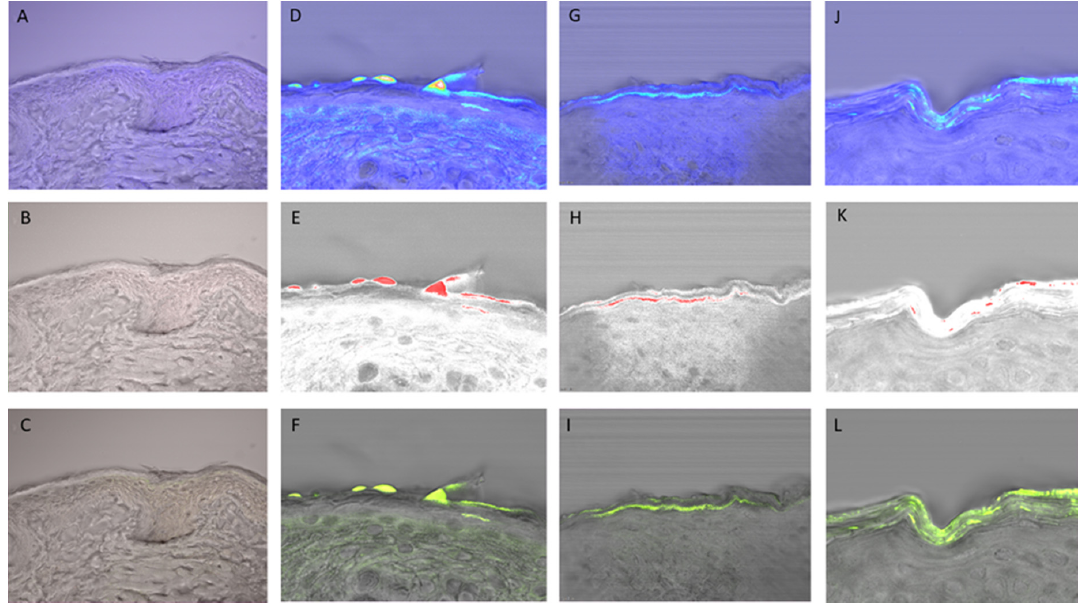
Figure 5. Penetration of fluorescent dye (coumarin): ( A – C ) control skin without fluorescent dye; ( D – F ) suspended fluorescent dye in oil phase; ( G – I ) encapsulated in nanoemulsion, 1 h after application on skin; ( J – L ) encapsulated in nanoemulsion, 4 h after application on